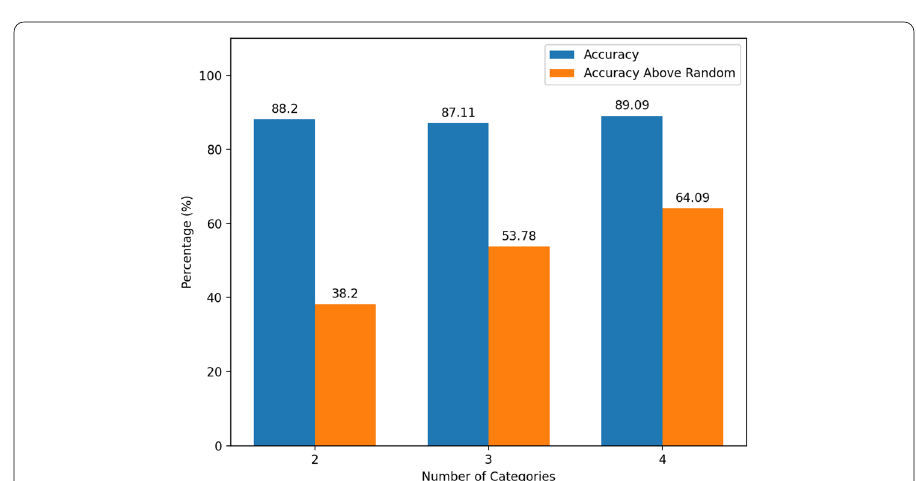
Fig. 8 Accuracy of the model trained on synthetic data as the number of categories in the classification varies. The 2 category model trained between cat and dogs, the 3 category introduced bikes and the 4 category added the cars